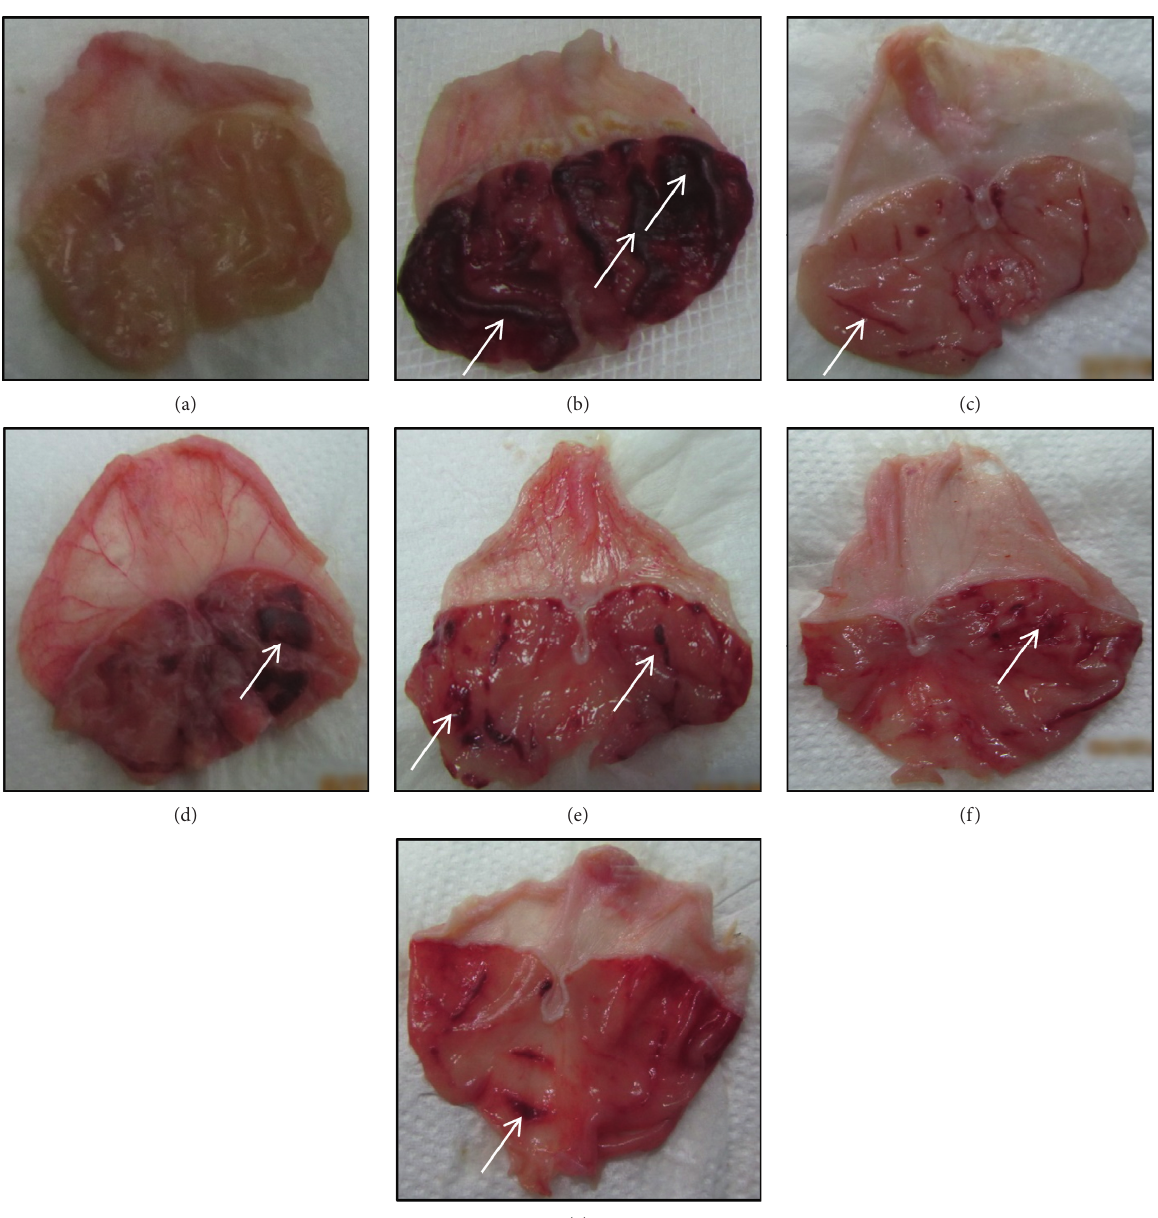
Figure 3: Effect of QP, QG, QB, and QF on the macroscopic status of the rats’ stomachs. (a) Normal stomach. (b) Stomach treated with absolute EtOH at dose of 5mL/kg showing severe haemorrhagic stripped lesions along the ridges of mucosa (white arrow). (c) Stomach treated with omeprazole (20mg/kg) showing significant reduction in the lesioned strips. (d) Stomach treated with QP (quinoa seeds cooked under high pressure, 200mg/kg) showing moderated ulcer lesions. (e) Stomach treated with QG (first stage-germinated quinoa seeds, 200mg/kg) showing mild ulcerated strips. (f) Stomach treated with QB (quinoa seeds fermented by Lactobacillus plantarum bacteria, 200mg/kg) and (g) stomach treated with QF (quinoa seeds fermented by Rhizopus oligosporus fungus, 200mg/kg) showing clear reduction in lesion areas of the